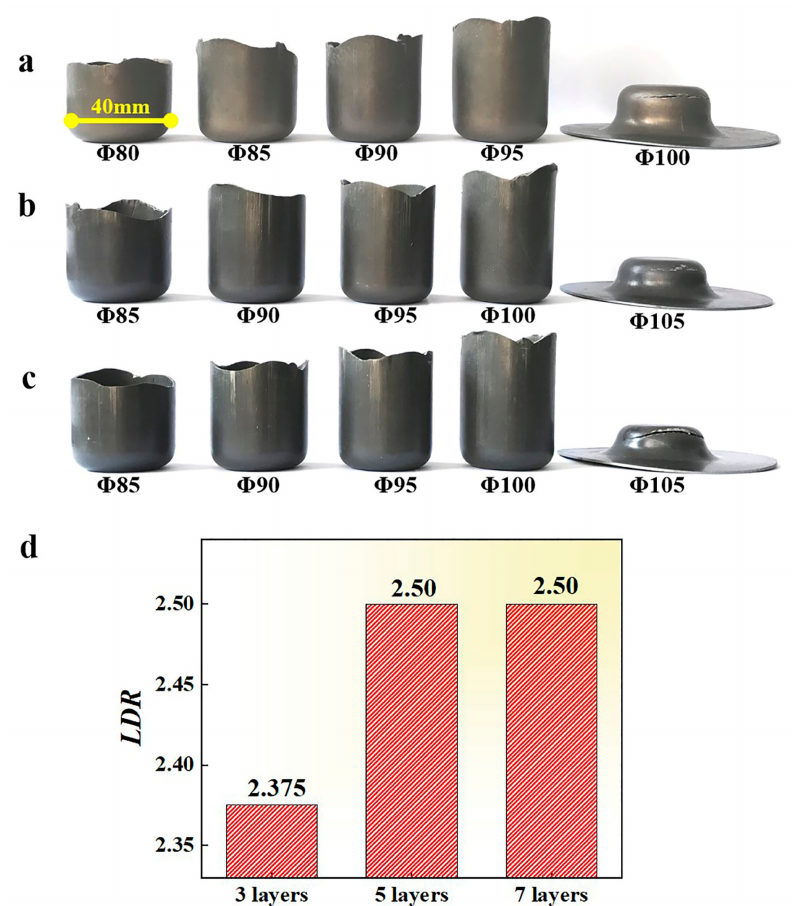
Figure 4. The deep-drawing parts of Ti/Al multilayered composites with ( a ) three layers, ( b ) five lay- ers, ( c ) seven layers with various diameters; and ( d ) limit-drawing ratio ( LDR ) of Ti/Al multilayered composites. (where Φ 40 mm marked in deep-drawing parts refers to the punch diameter, and Φ 80 mm— Φ 105 mm refers to the blank diameter before deep-drawing).